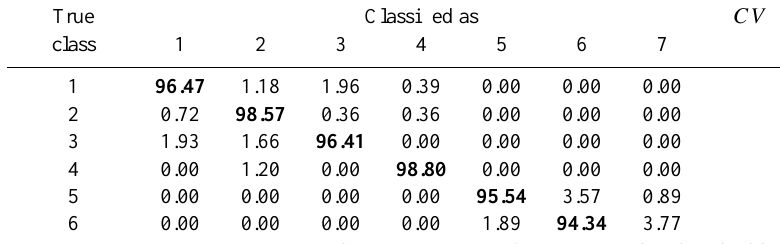
Table 4. Confusion matrix of CV for optimal weighted features in %.